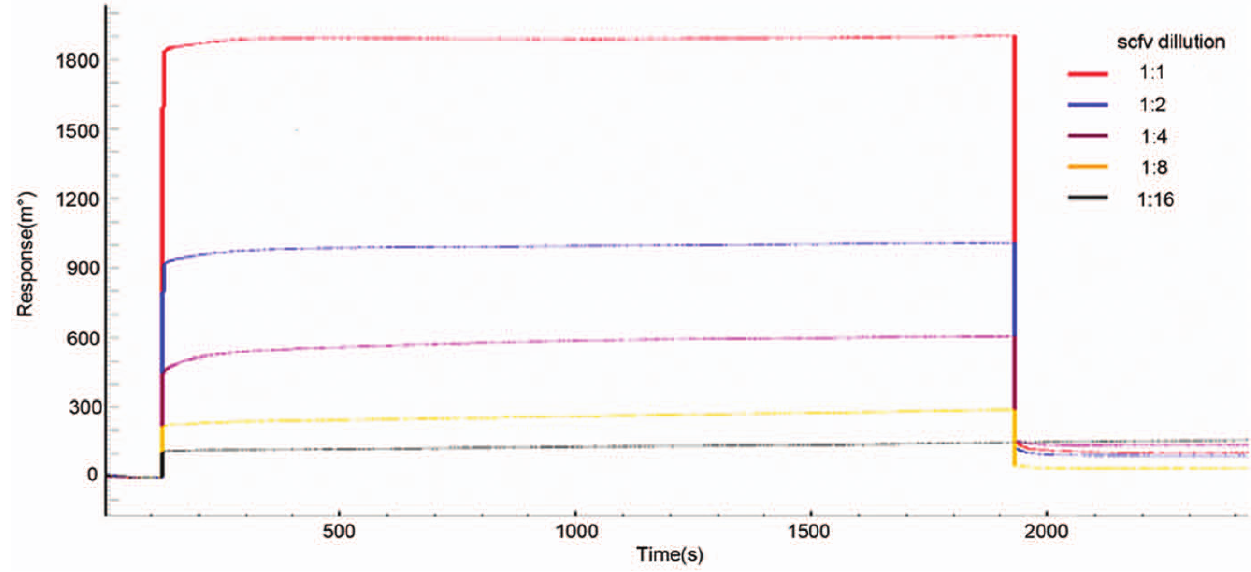
Figure 8. The calculation of association rate constants by SPR. 30-3 scFv was appropriately diluted in PBS at five antibody concentrations.